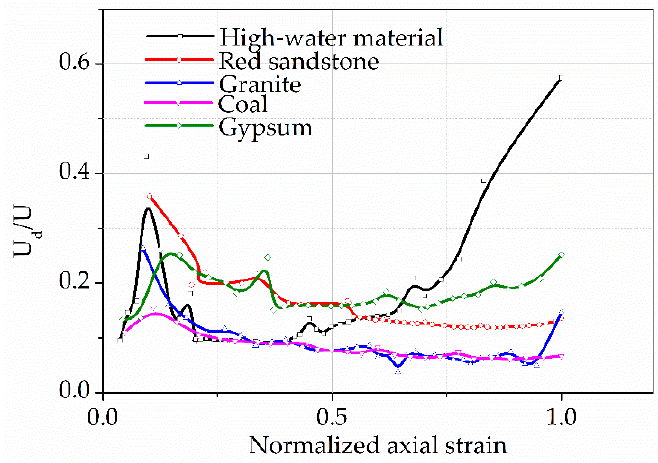
Figure 7. Evolution of the ratio of dissipated energy to total input energy for the rocks.